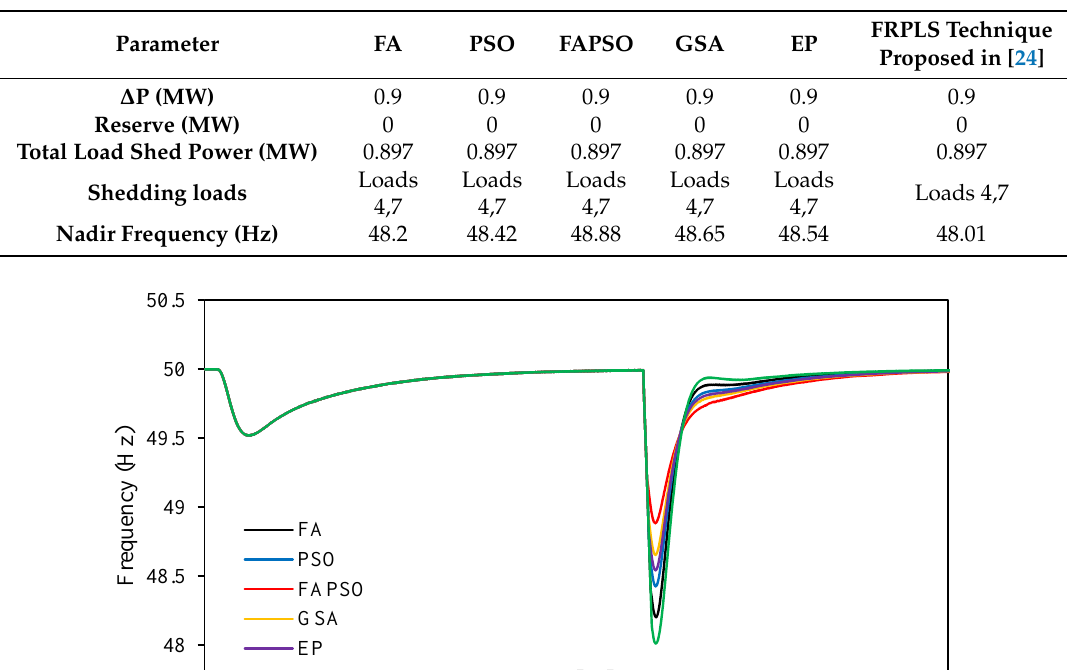
Table 10. The UFLS parameters for load increment of 0.9 MW after islanding.